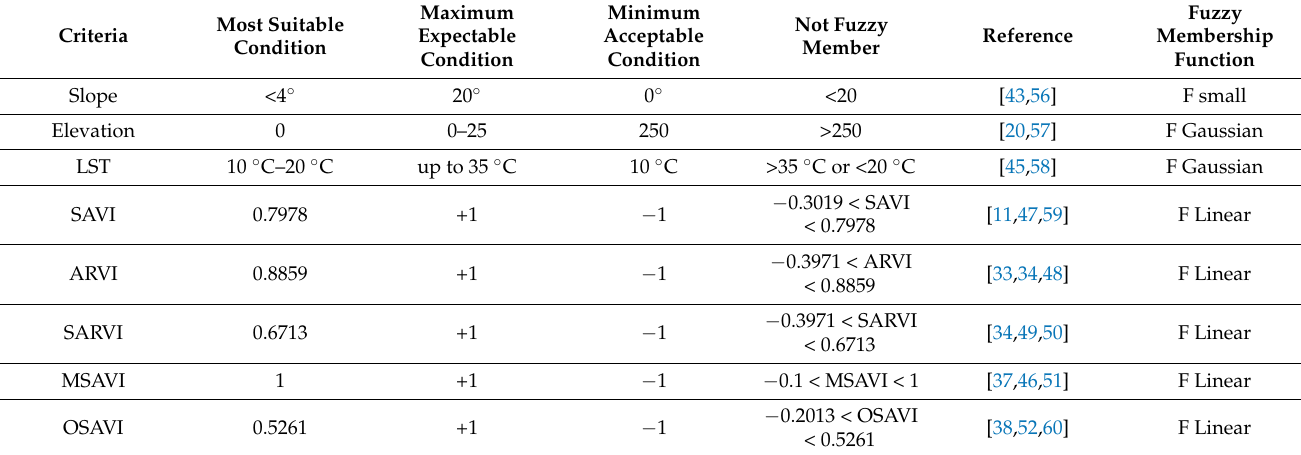
Table 3. Criteria reclassification for Fuzzy membership